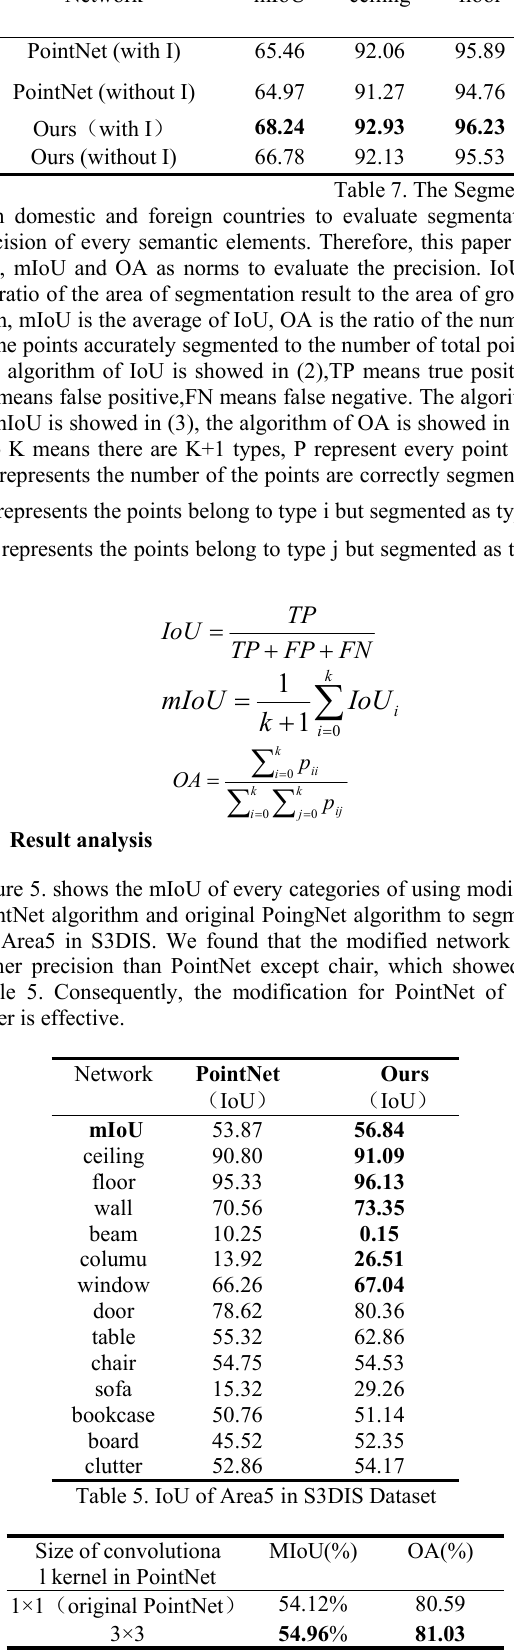
Table 6. Segmentation Results of PointNet with Different Convolution Kernels on